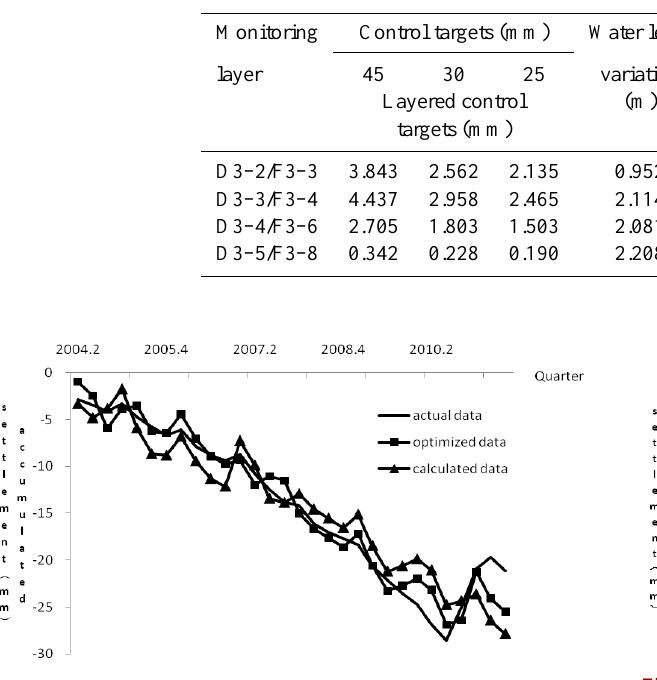
Figure 5. The calculated, actual and optimized value of F3–6.